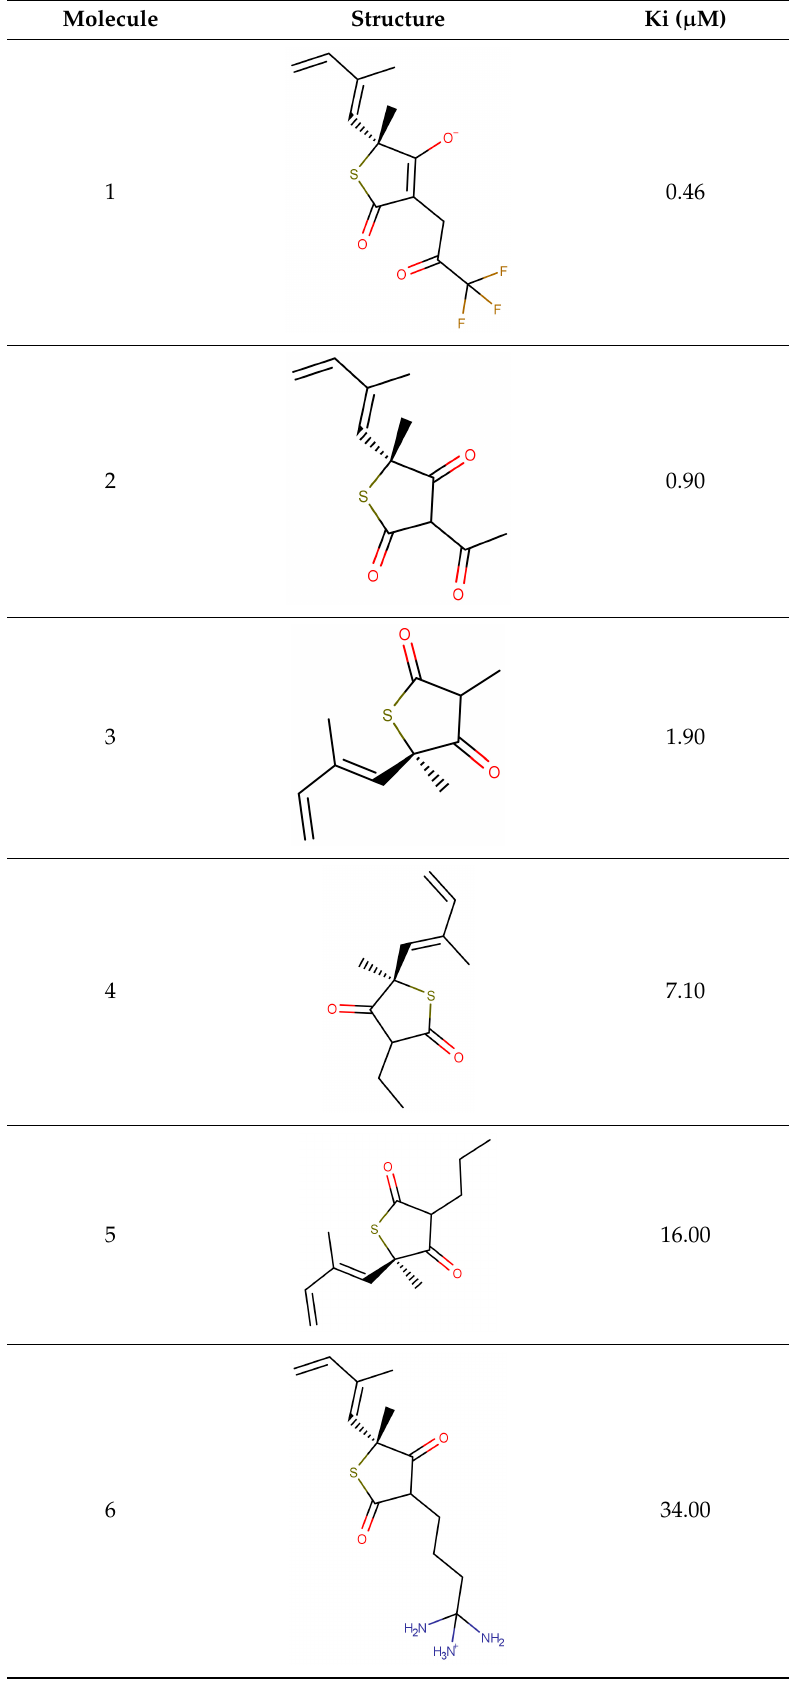
Table 6. KasA inhibitors selected for construction and evaluation of pharmacophore models.